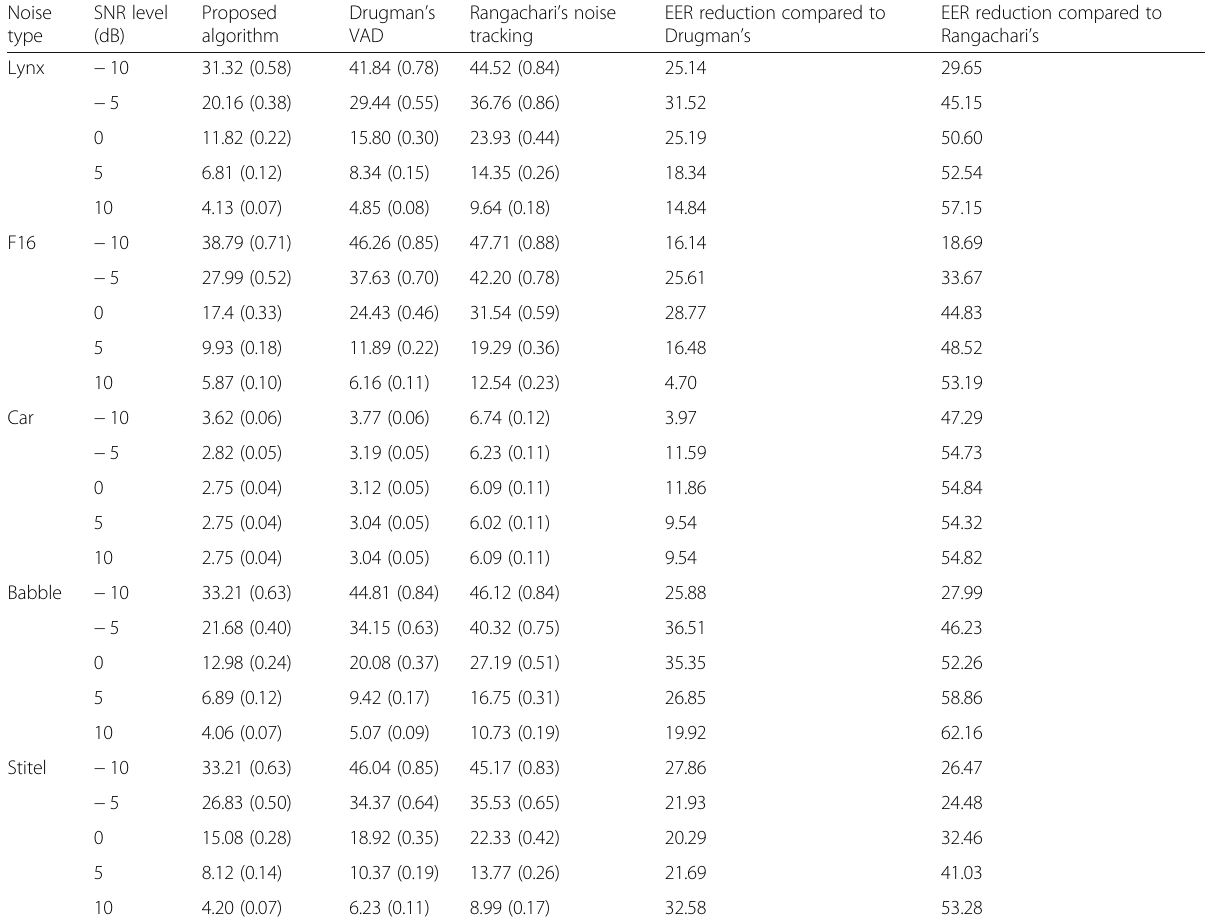
Table 6 Female speaker verification results of i-vector method in terms of percent EER (minDCF) for the proposed algorithm, Drugman ’ s VAD method [27], and Rangachari ’ s noise tracking method [21]. The last columns show the relative percent EER reduction rates compared to Drugman ’ s VAD and Rangachari ’ s method, respectively